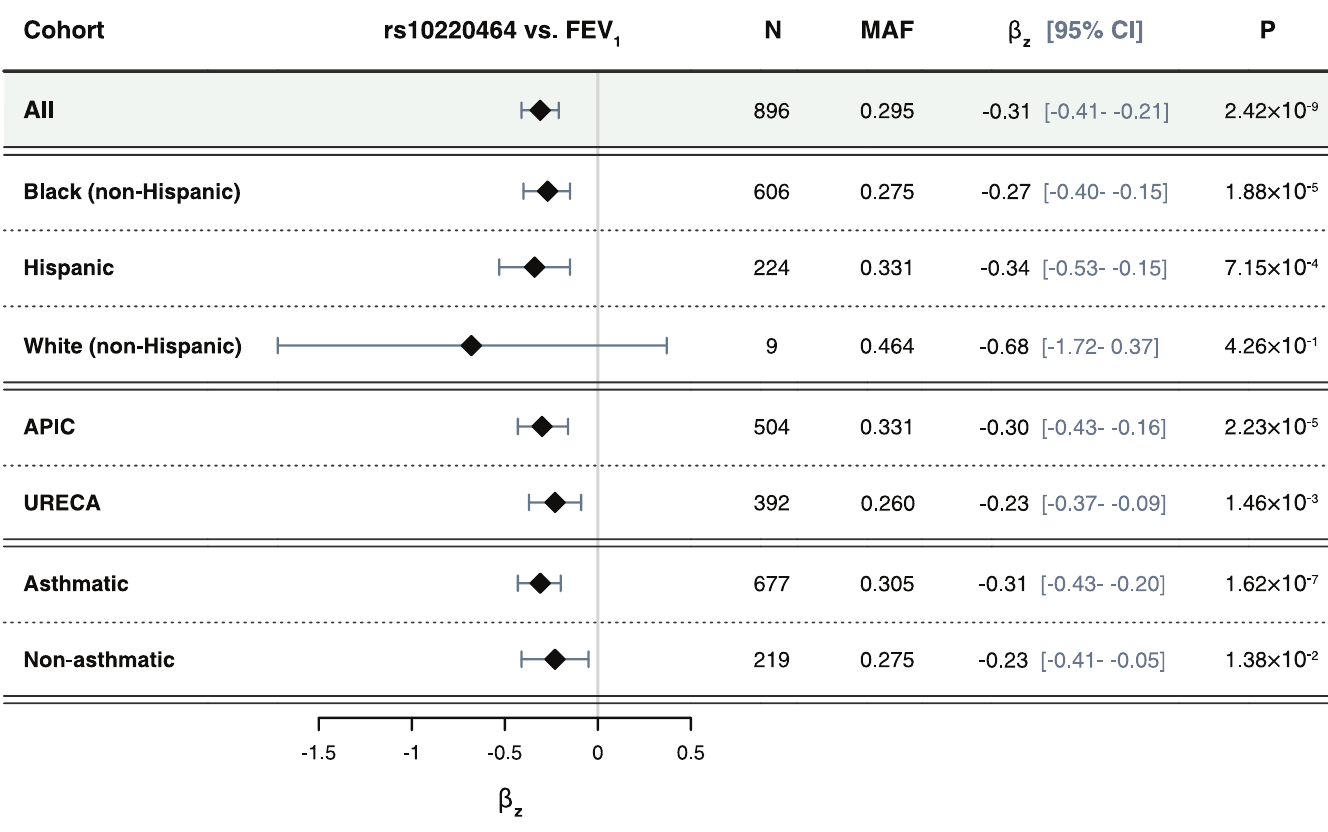
Fig 4. Rs10220464 effect size heterogeneity. A forest plot of the associations between rs10220464 and FEV 1 (% predicted) are shown for distinct sub-cohorts distinguished by self-identified race/ethnicity, study, and asthma status. β z , the association effect size between the rs10220464 allele count and the adjusted and normalized FEV 1 (% predicted) values; FEV 1 , forced expiratory volume in one second; N, total number of individuals included in the association test; MAF, minor allele frequency within the sub-cohort; P, the association p-value.